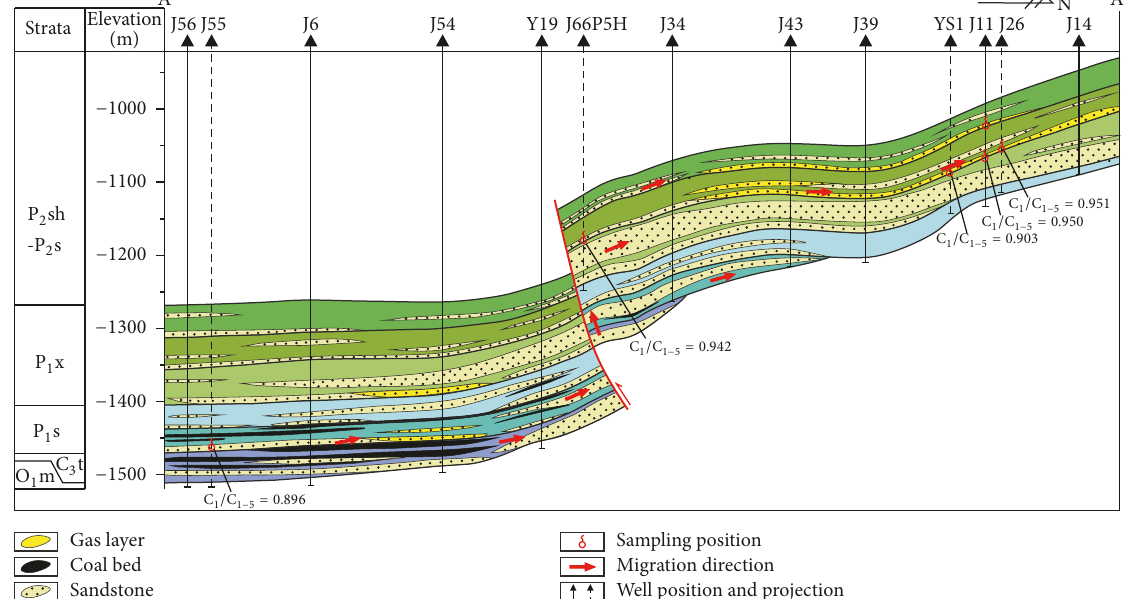
Figure 11: Gas filling model of the Upper Paleozoic tight gas in the Hangjinqi area, and the position of the section A-A 󸀠 is indicated in Figure 1 (modified after Li et al.